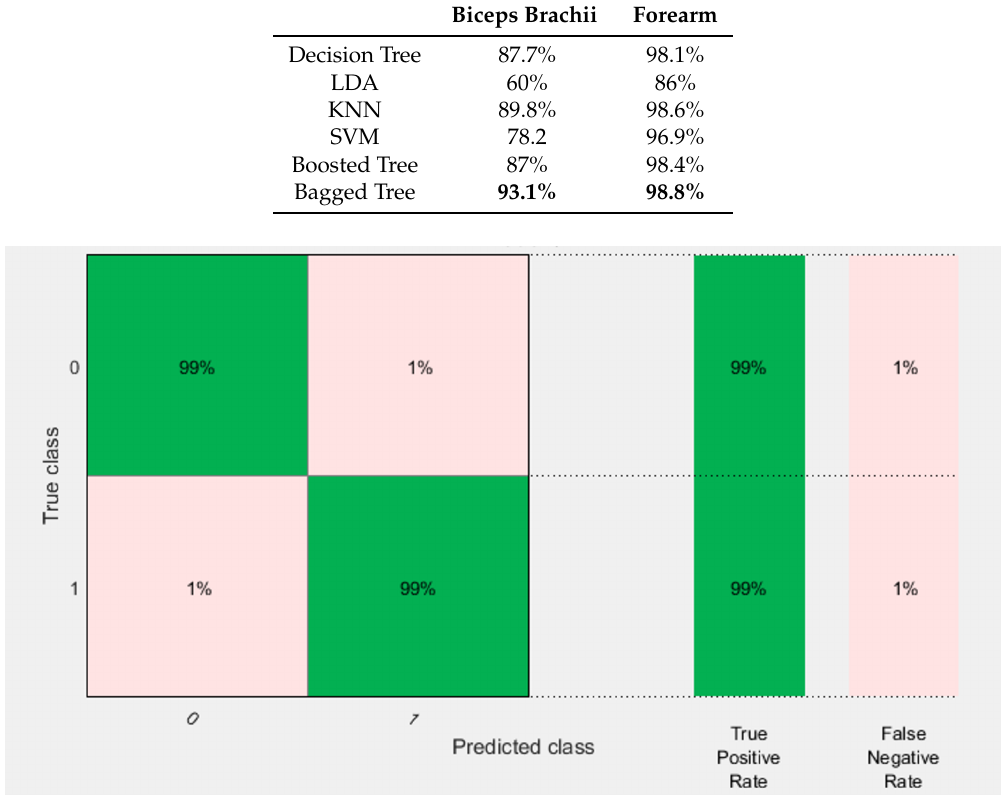
Figure 15. Confusion matrix of EMG measured from forearm muscle bagged tree classifier.